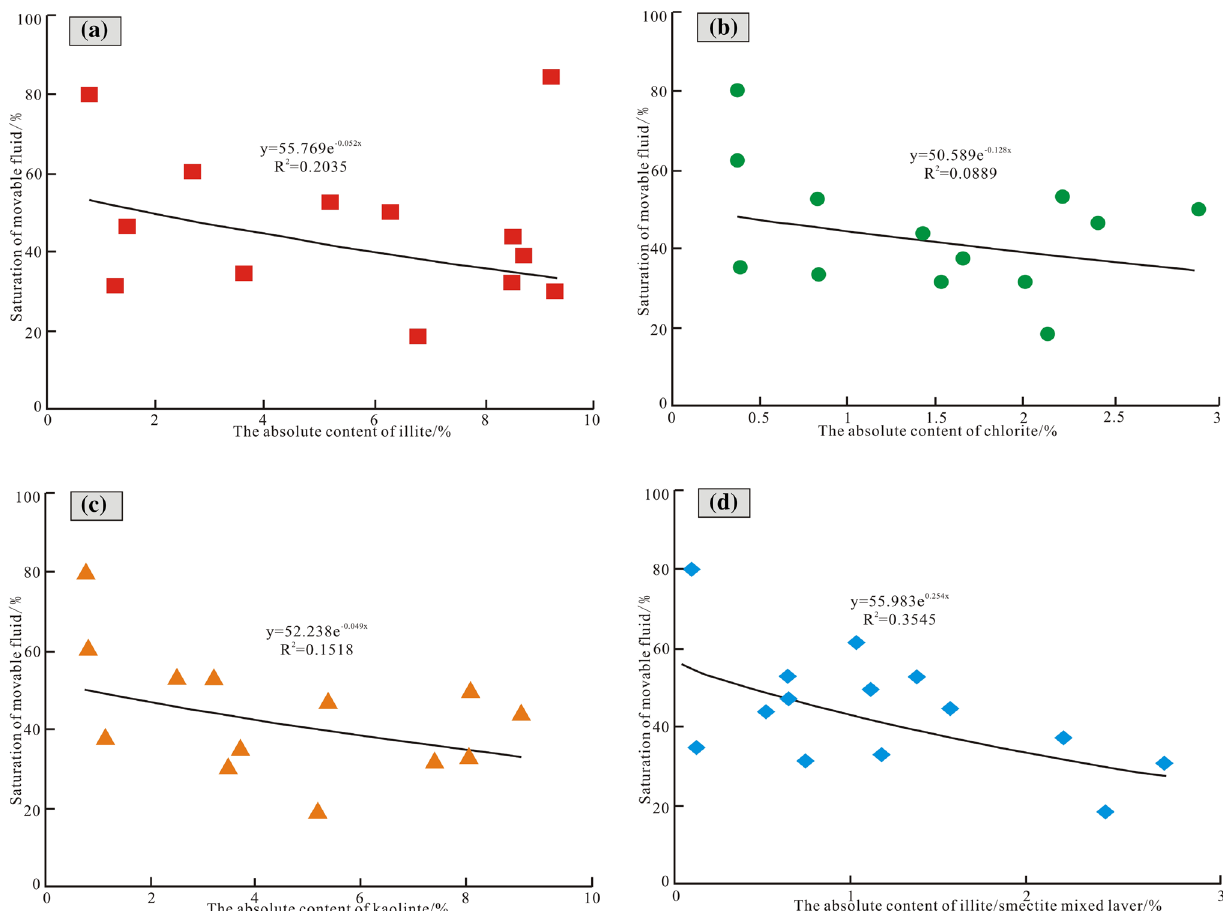
Fig. 9 Relationship between clay mineral contents and movable fluid saturation in Chang 8